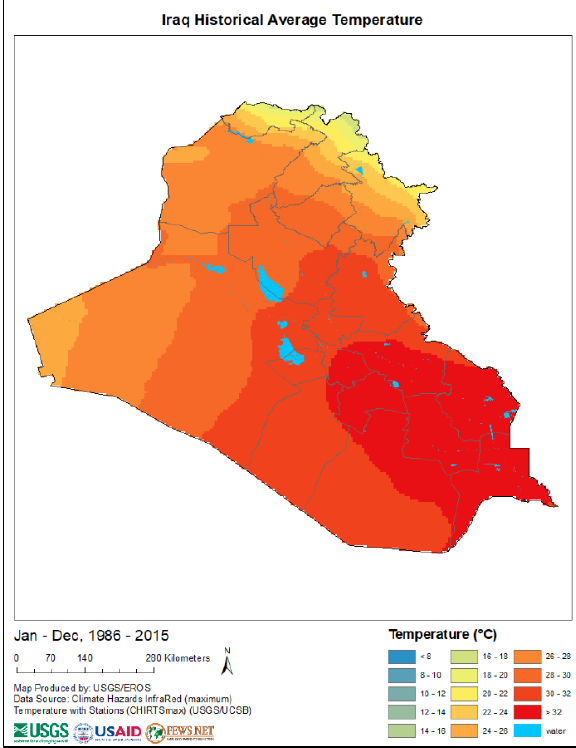
Figure 2. Average temperature historical map of Iraq (USGS).